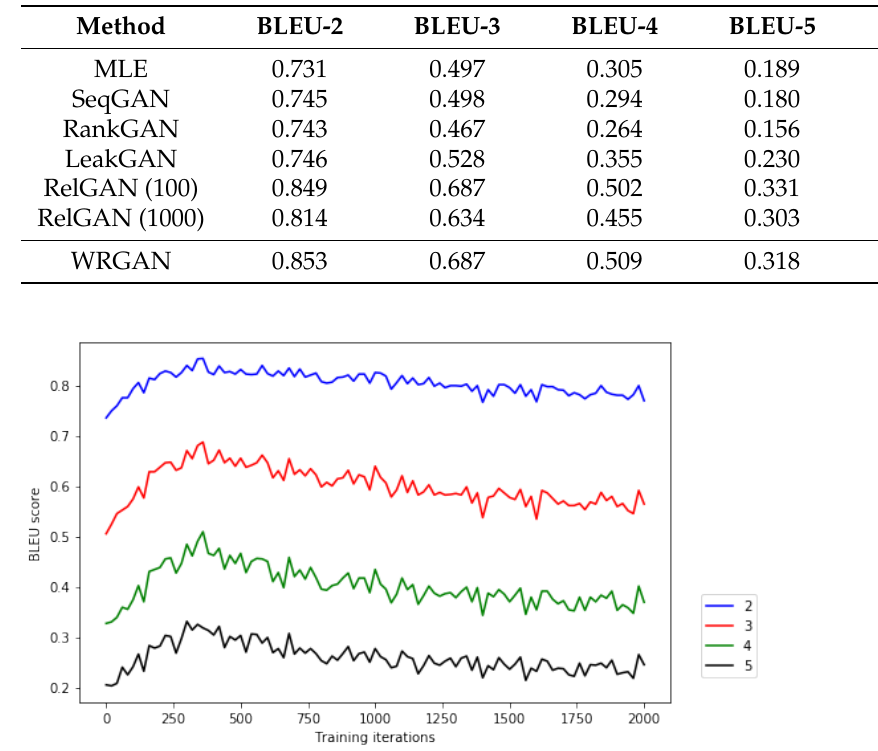
Figure 4. The BLEU scores for Common Objects in Context (COCO) image captions, where Dimension =